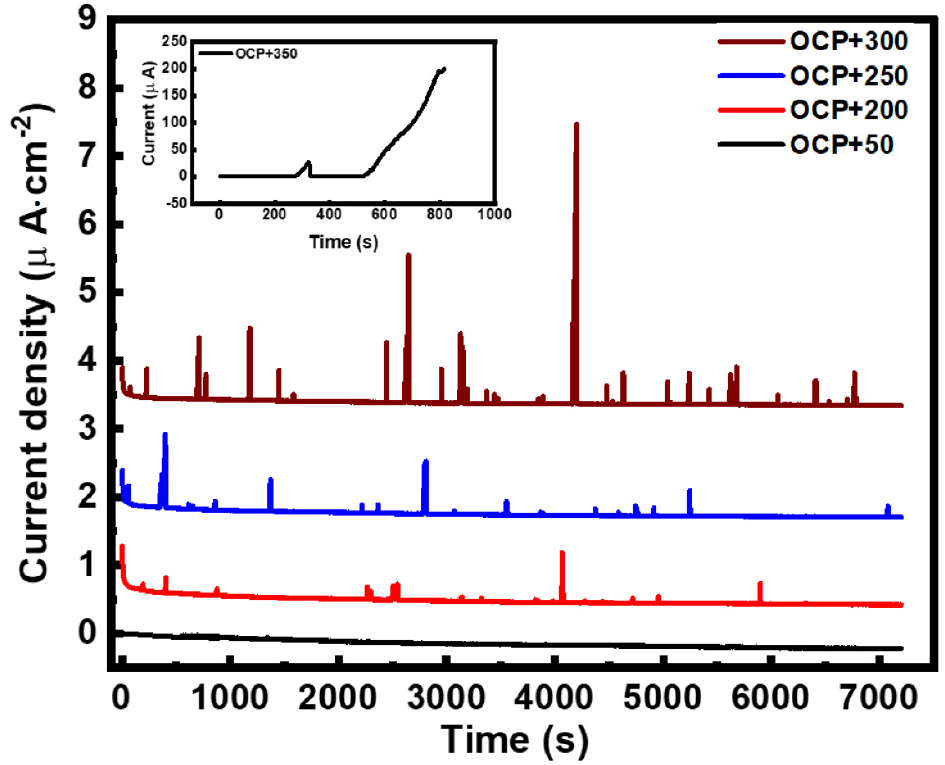
Figure 3. Chrono-amperometric curves were obtained from the staircase potentiostatic test carried out on the MMSS steel at 20 °C with 35.5 g/L NaCl in a saturated CO 2 environment (pH~5).